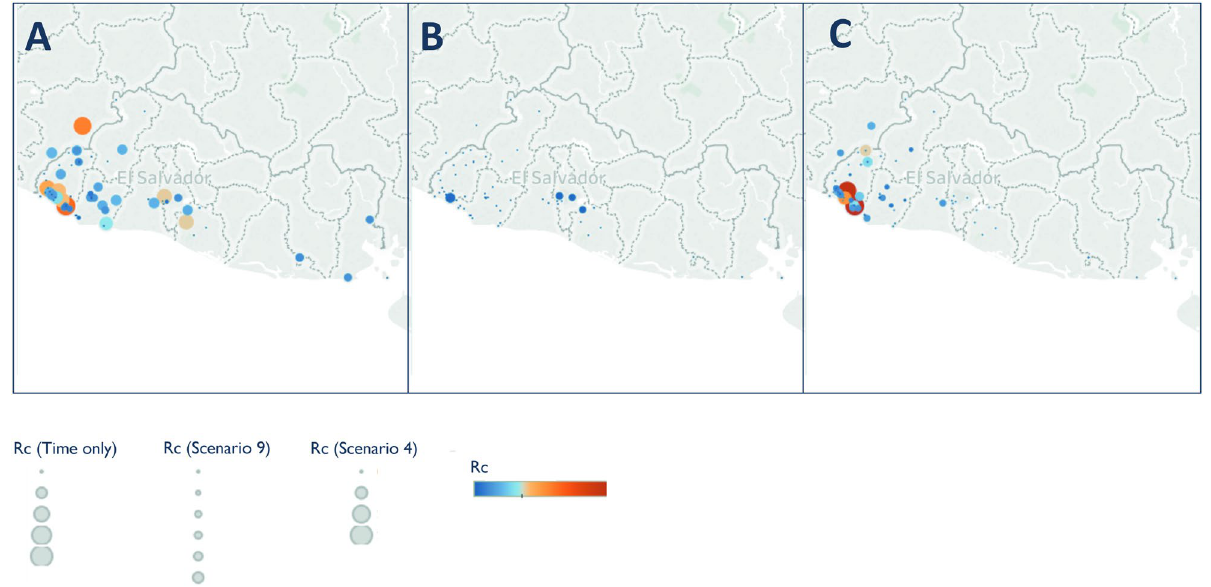
Figure 5. Map of Rc estimates for El Salvador Map of ( A ) time-only ( B ) best scenario by AIC (Scenario 9) and ( C ) Scenario 4, representing an assumption of little long-distance transmission and few unobserved cases.